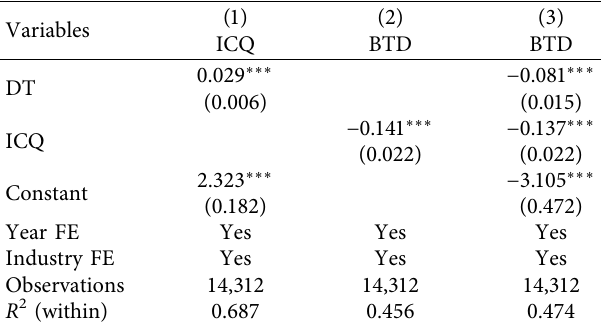
Table 5: Digital transformation, quality of internal controls, and corporate tax